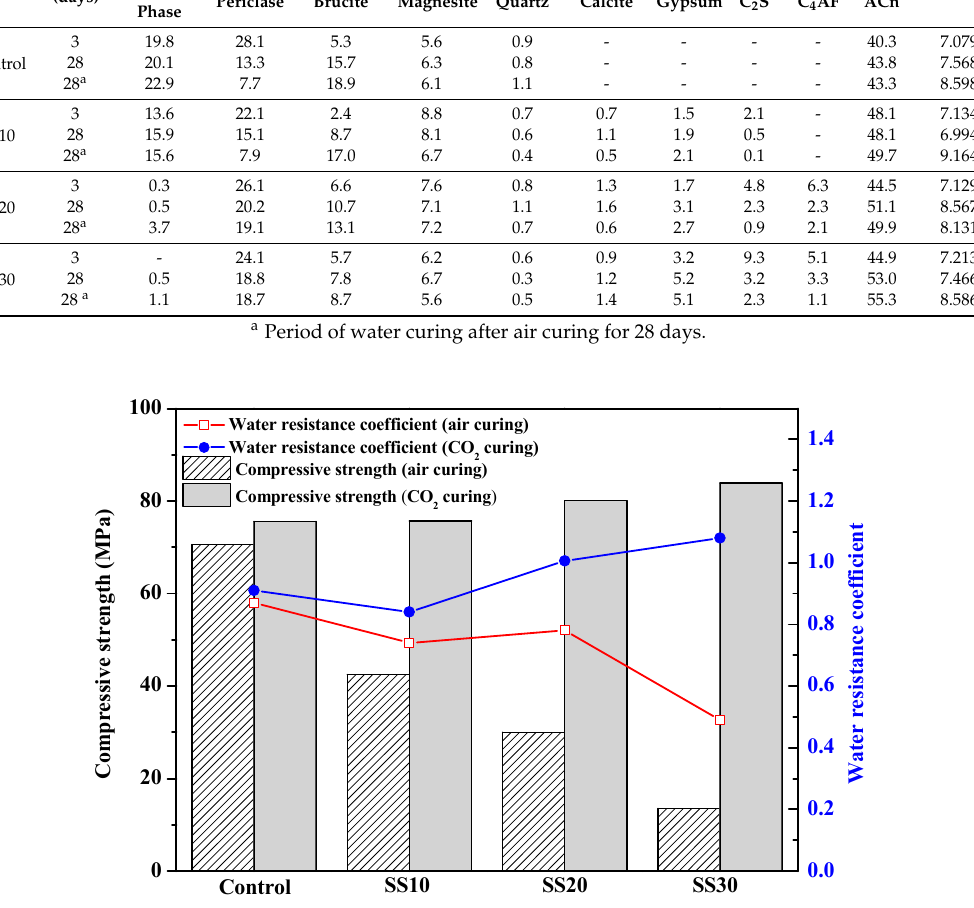
Figure 4. Compressive strengths and water-resistance coefficient of the control, SS10, SS20, and SS30 with and without CO 2 treatment after water immersion for 28 days.